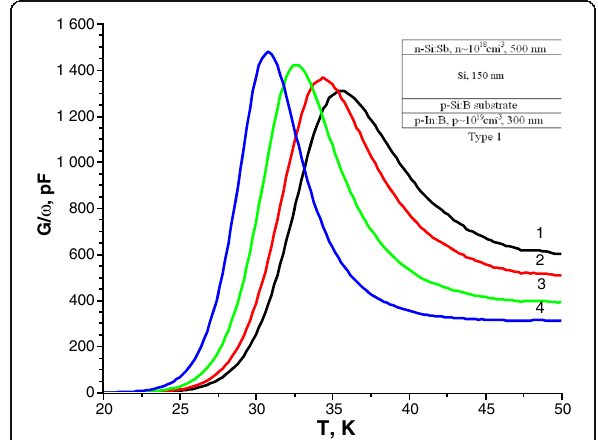
Fig. 1 Temperature spectra of conductance for sample type 1 measured at the applied bias voltage of – 0.5 V and various frequencies of the test signal 1 2000 kHz, 2 1500 kHz, 3 1000 kHz, and 4 500 kHz. The inset shows the structure of samples